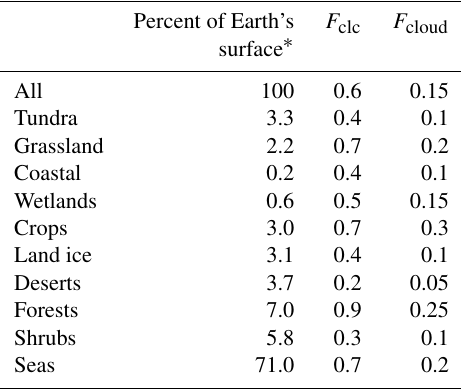
Table 2. Surface coverage of ecosystems on Earth’s surface (Bur- rows et al., 2009b); approximate cloud coverage F clc above the ecosystems, estimated based on maps of cloud cover data obtained by MODIS Terra for spring (2000–2011); and estimated time frac- tion bacteria spend in clouds ( F cloud